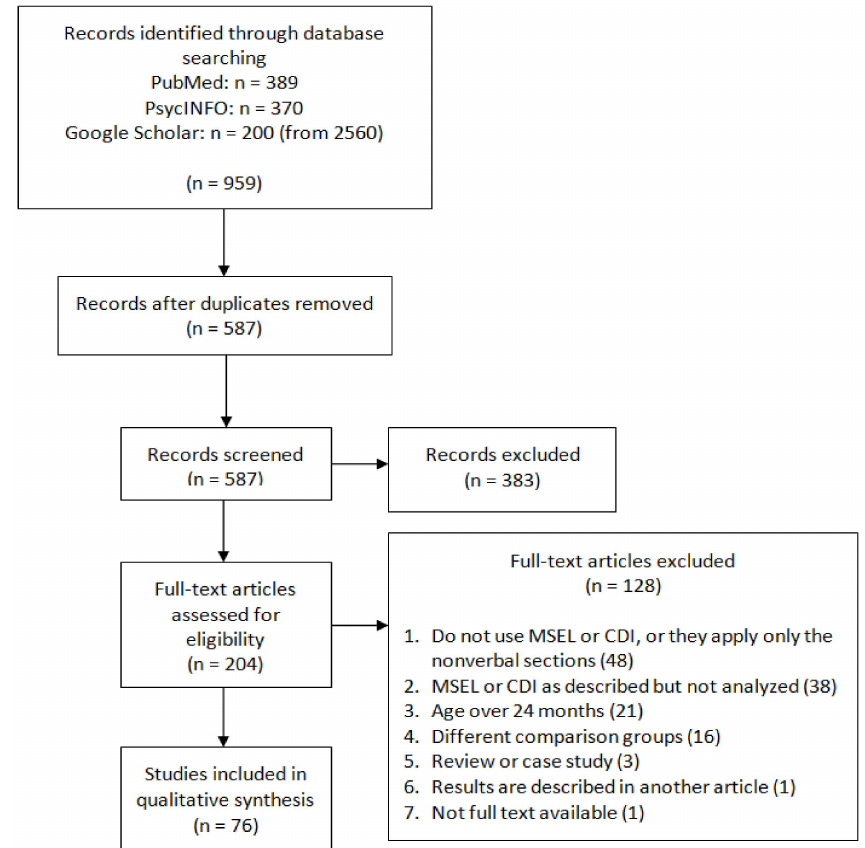
Figure 1. PRISMA flow diagram of the systematic review